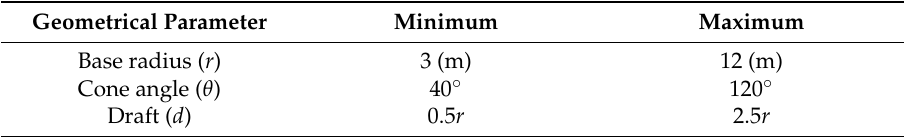
Table 3. Range of geometrical